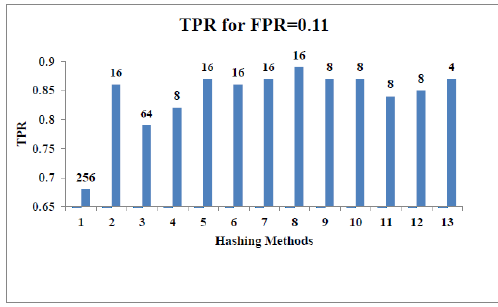
Figure 14. TPR vs. FPR: Decrease Contrast.